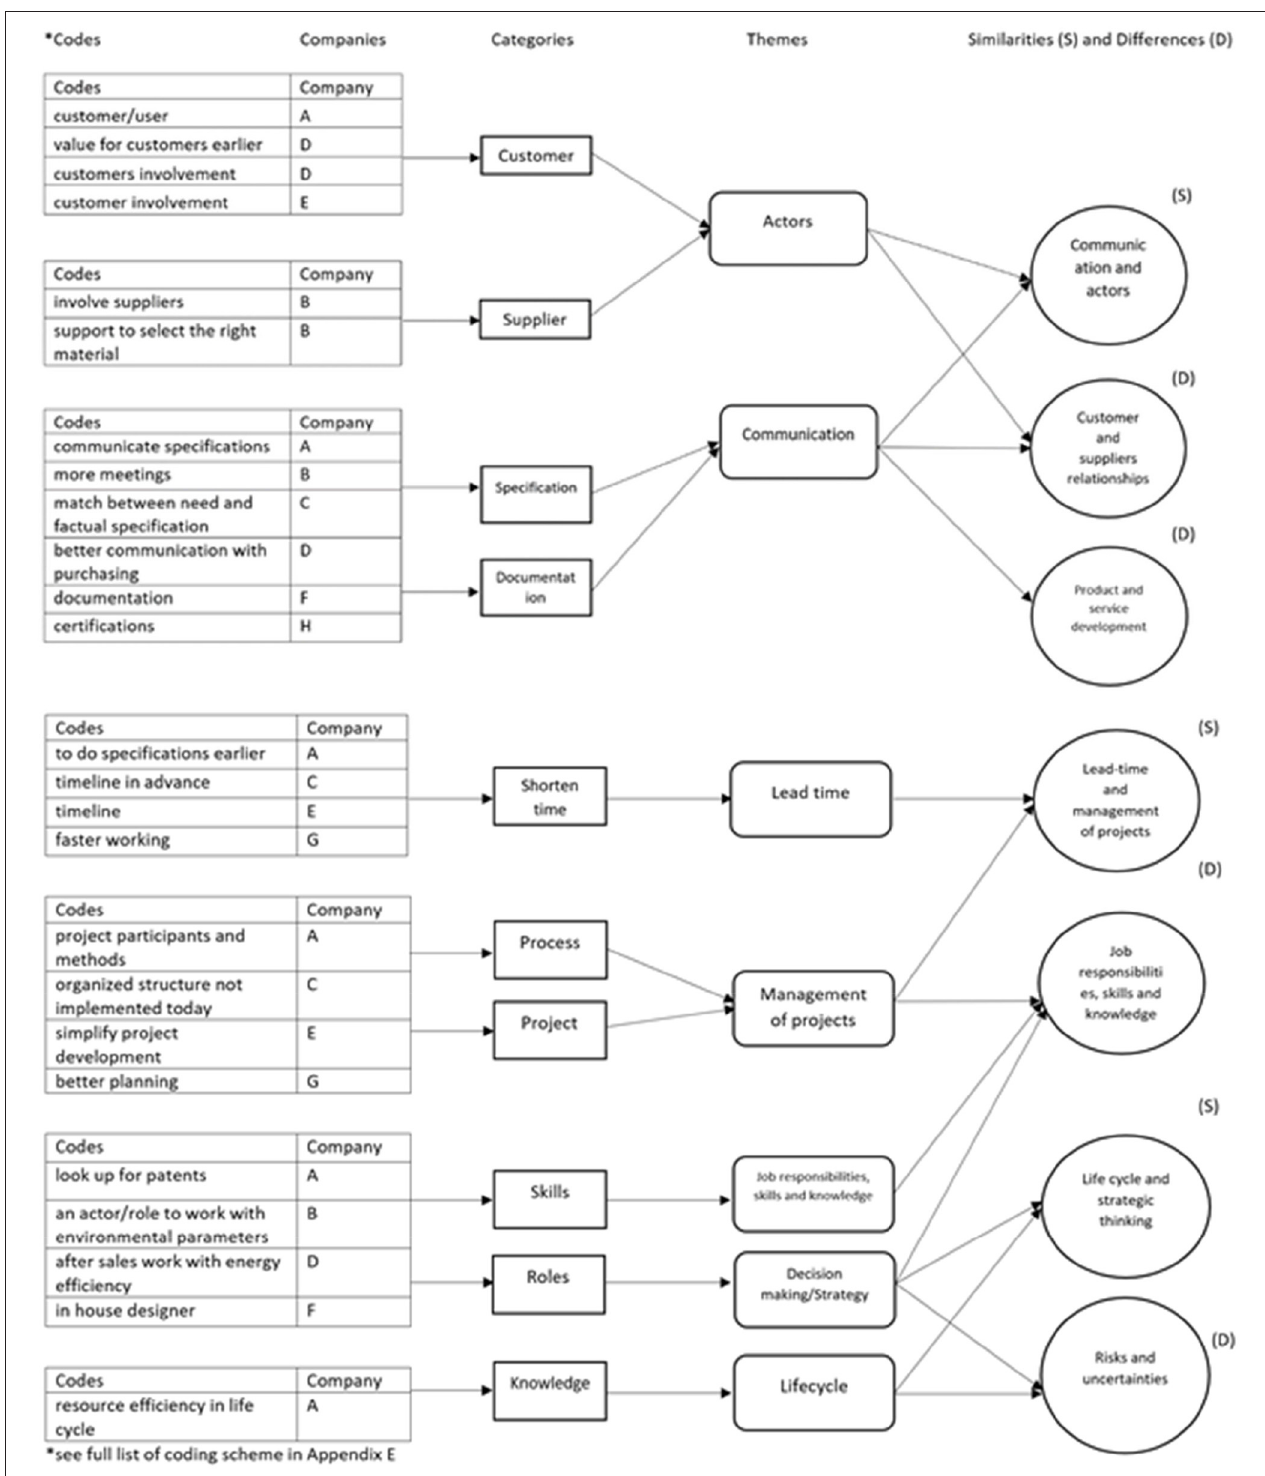
FIGURE 1 | Coding tree showing the analysis of the